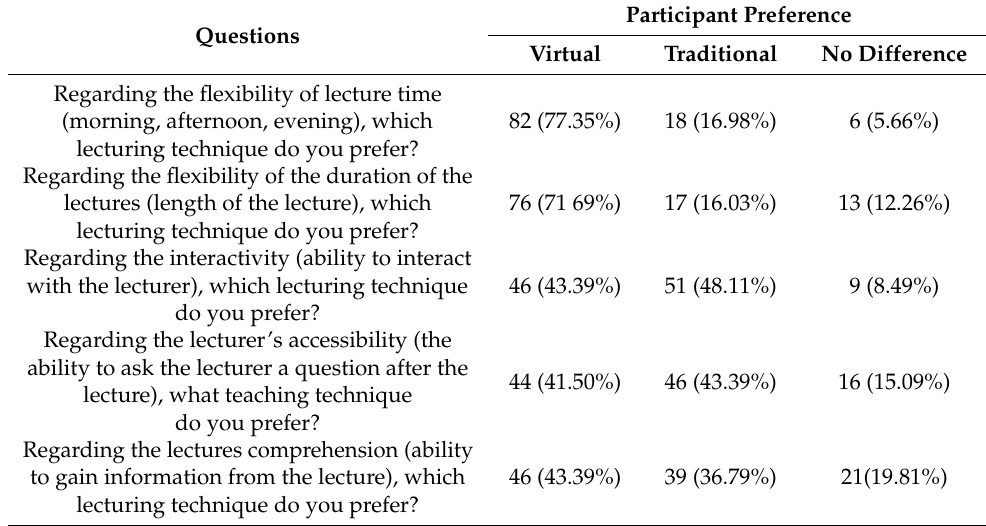
Table 1. Participants’ preferences regarding the traditional and virtual